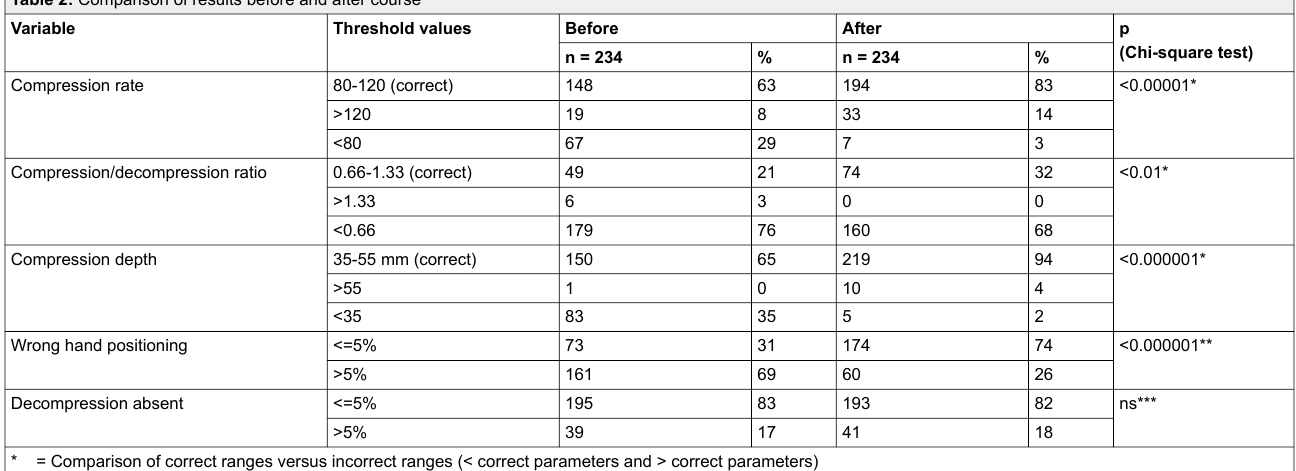
Table 2: Comparison of results before and after course